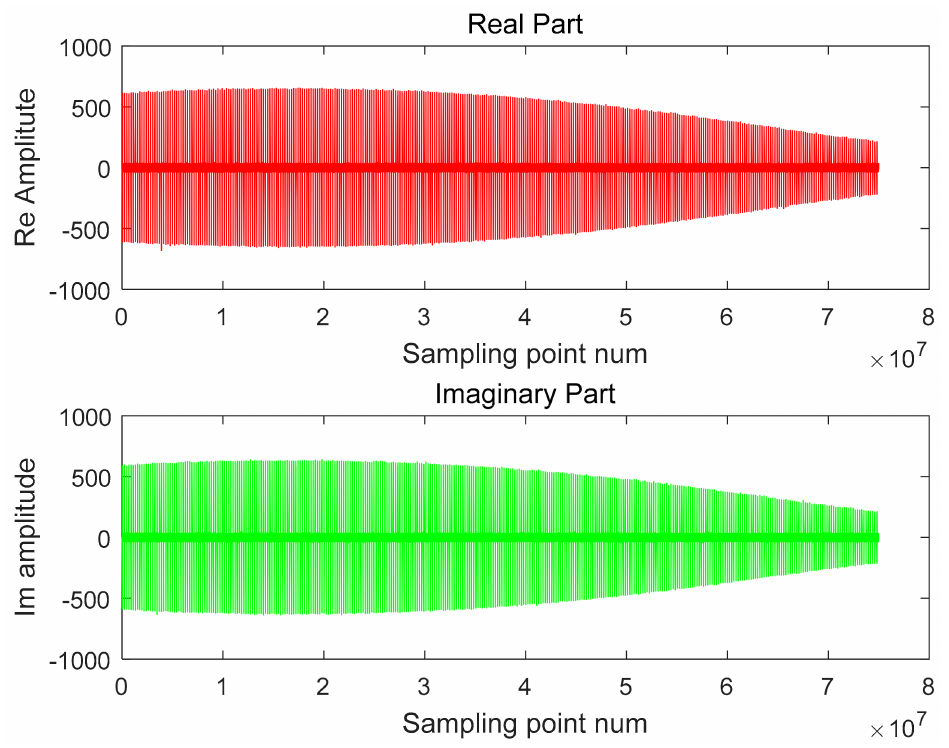
Figure 7. Complex sampling data recorded by the ground receiver.